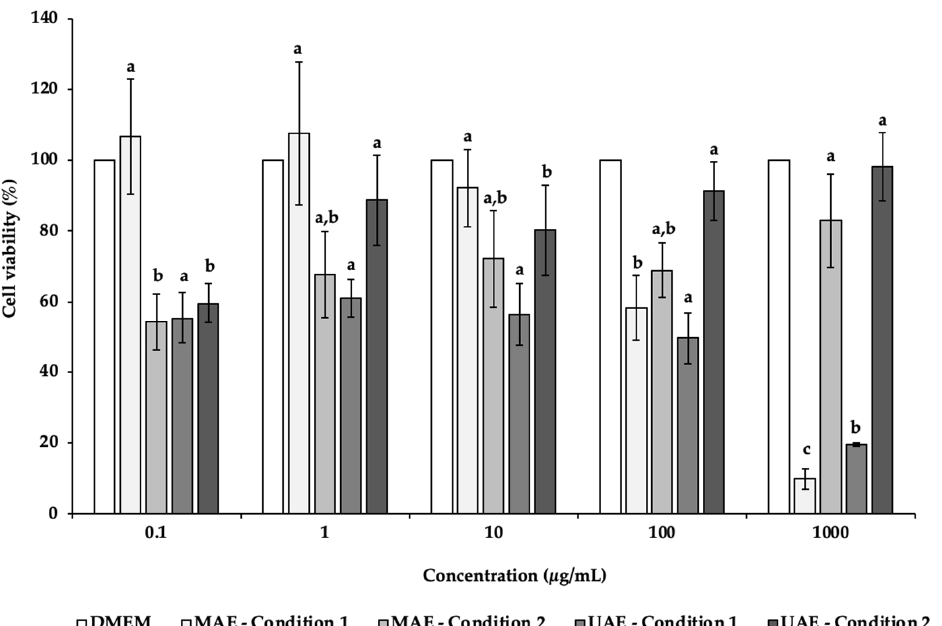
Figure 2. Effects of C. pepo extracts obtained by UAE and MAE exposure on the viability of NSC-34 cells at different concentrations (0.1–1000 µ g/mL), as measured by the MTT assay. Values are expressed as mean ± standard deviation ( n = 3). Different letters indicate significant differences between concentrations of the same sample ( p < 0.05), according to Tukey’s HSD test.